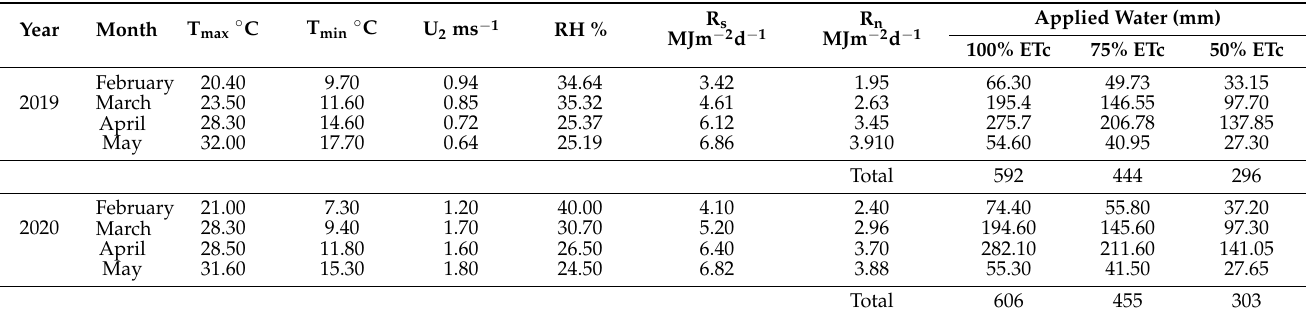
T max , T min , U 2 , RH, Rs, and R n indicate maximum temperature, minimum temperature, average wind speed, relative humidity, mean solar radiation, and mean net solar radiation,